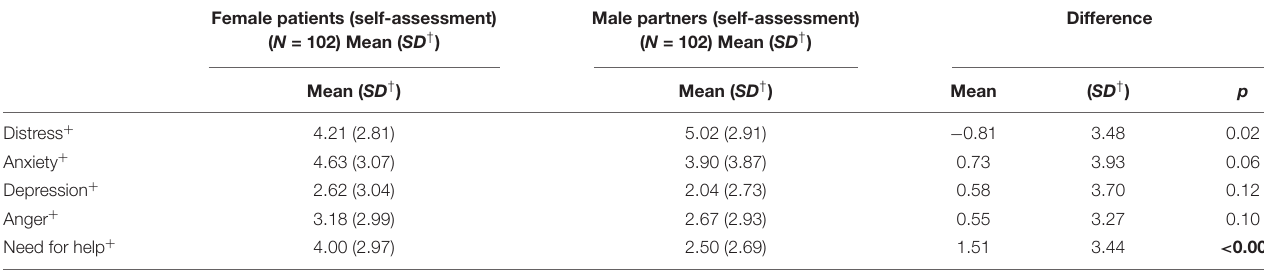
TABLE 2 | Mental burden in female patients with breast cancer and their male partners (self-assessment).